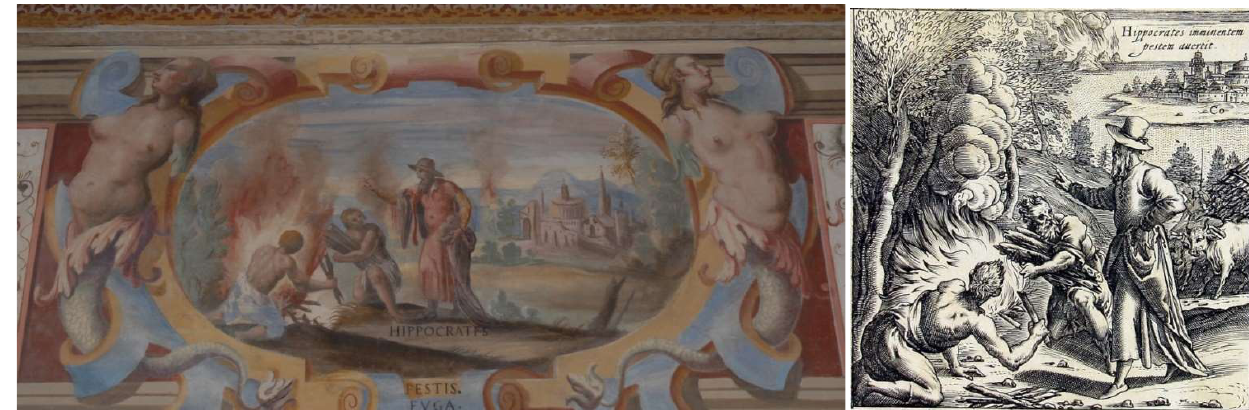
Figure 8. Left : The second oval painting of the southern wall, showing two men who are burning infected materials according to the directives of Hippocrates. Right : Vignette of Giunti’s edition that can be associated with the oval